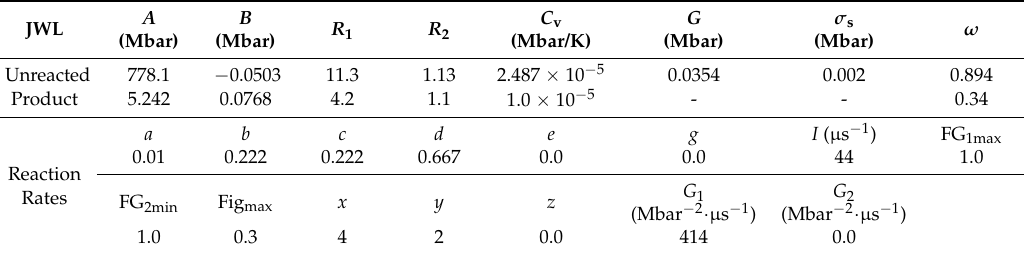
Table 5. Parameters of Lee-Tarver ignition growth model for the compBJJ1